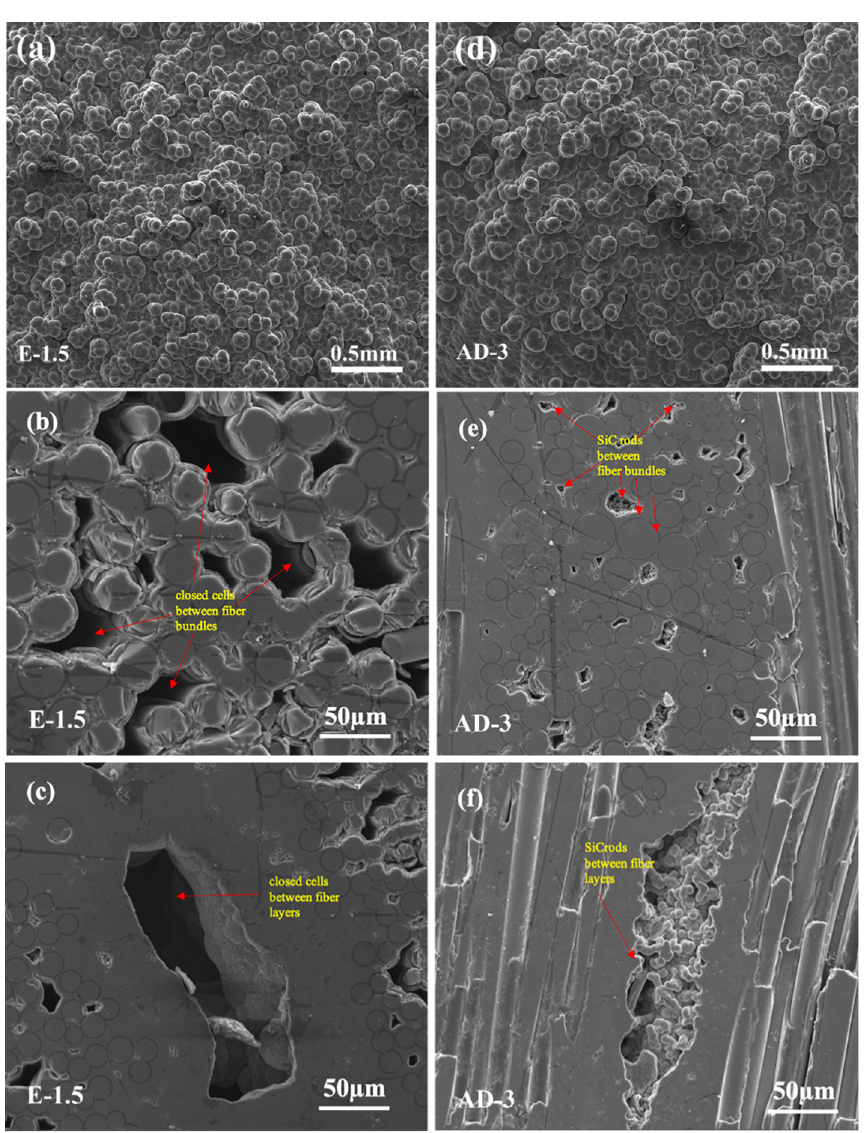
Figure 8. Surface and cross-sectional microstructures of SiCNW-containing SiC f /SiC composites after densification: ( a ) surface of E-1.5; ( b ) cross-section of inter-fiber bundles of E-1.5; ( c ) cross-section of fiber layer of E-1.5; ( d ) surface of AD-3; ( e ) cross-section of inter-fiber bundles of AD-3; and ( f ) cross-section of fiber layer of AD-3.